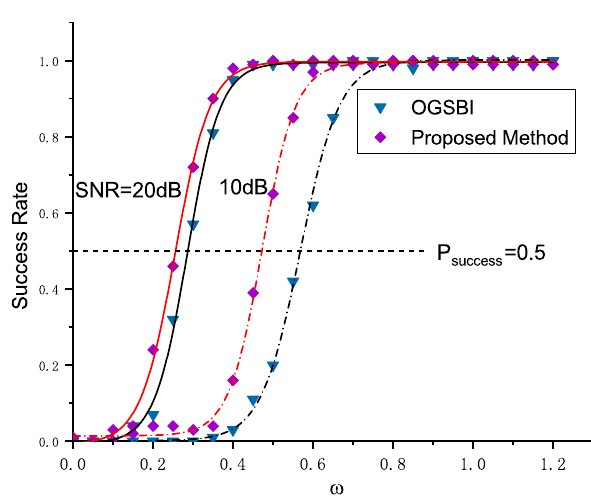
Figure 7. Success rate of separation using different algorithms and under different SNRs.